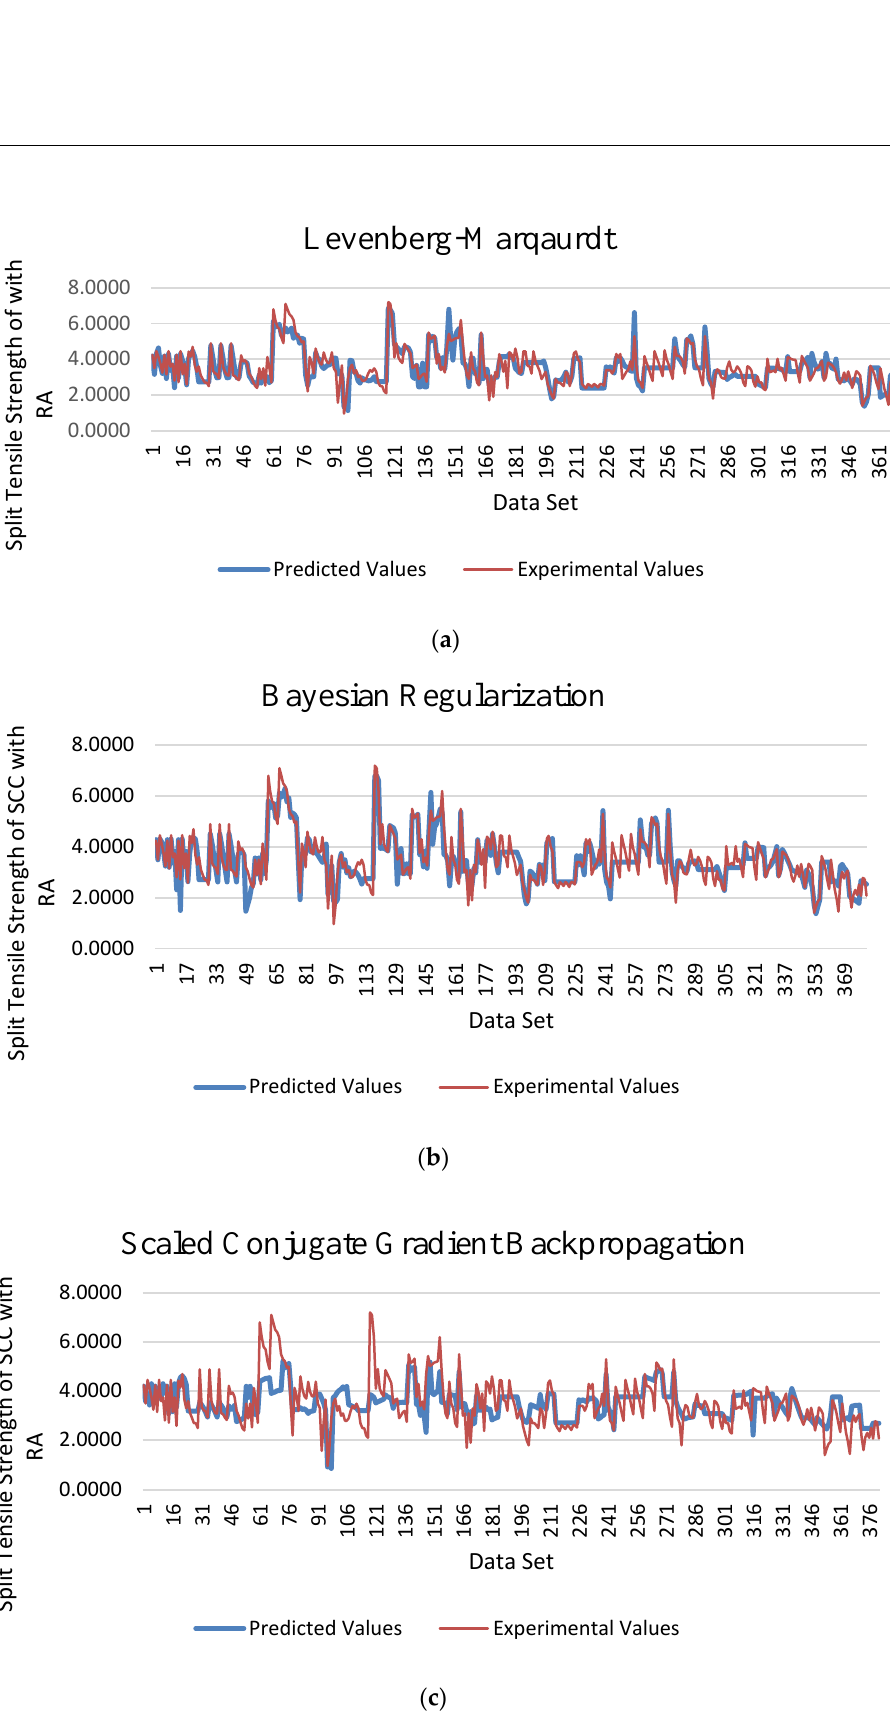
15 of 22 Figure 14. SCG algorithm regression graphs between the experimental and predicted tensile strength: ( a ) training; ( b ) validation; ( c ) testing, and ( d ) overall dataset. Finally, all the performance parameters results, i.e., the R-value and MSE of the over- all model with training, validation, and testing, are summarized in Table 6. These results indicate that Scaled Conjugate Gradient Backpropagation is rated as a below-par algo- rithm compared with LM and BR for predicting the splitting tensile strength of self-com- pacting recycled aggregate concrete. Table 6. Summary of different model evaluation parameters of SCGB algorithm. Step